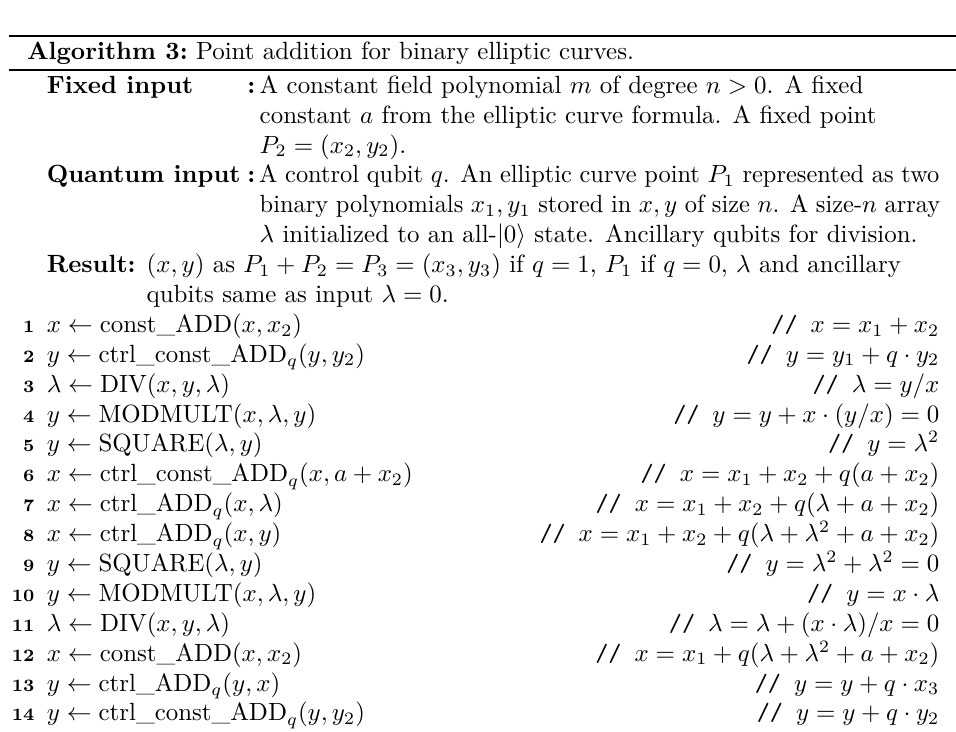
Algorithm 1 from Roetteler, Naehrig, Svore and Lauter [RNSL17] for the binary case gives